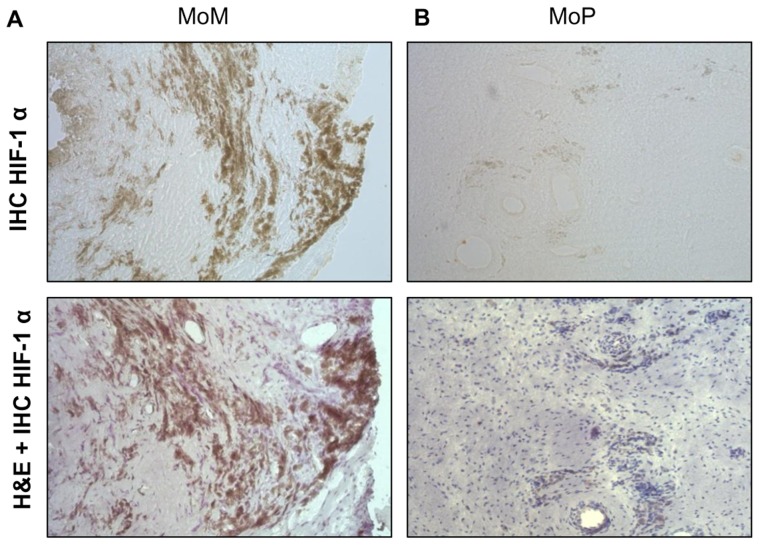
Immunohistochemistry analysis of HIF-1α protein expression in total hip replacements.(A) H&E staining and immunohistochemistry analysis of HIF-1α in peri-implant human tissue samples of a representative of n = 5 metal-on-metal hip replacements and (B) a representative of n = 10 metal-on-polymer hip replacements. All other tissues demonstrated similar patterns. All were revised for aseptic bone loss and pain where evidence of mild pseudotumor was present in all metal-on-metal tissues (original magnification 400x).